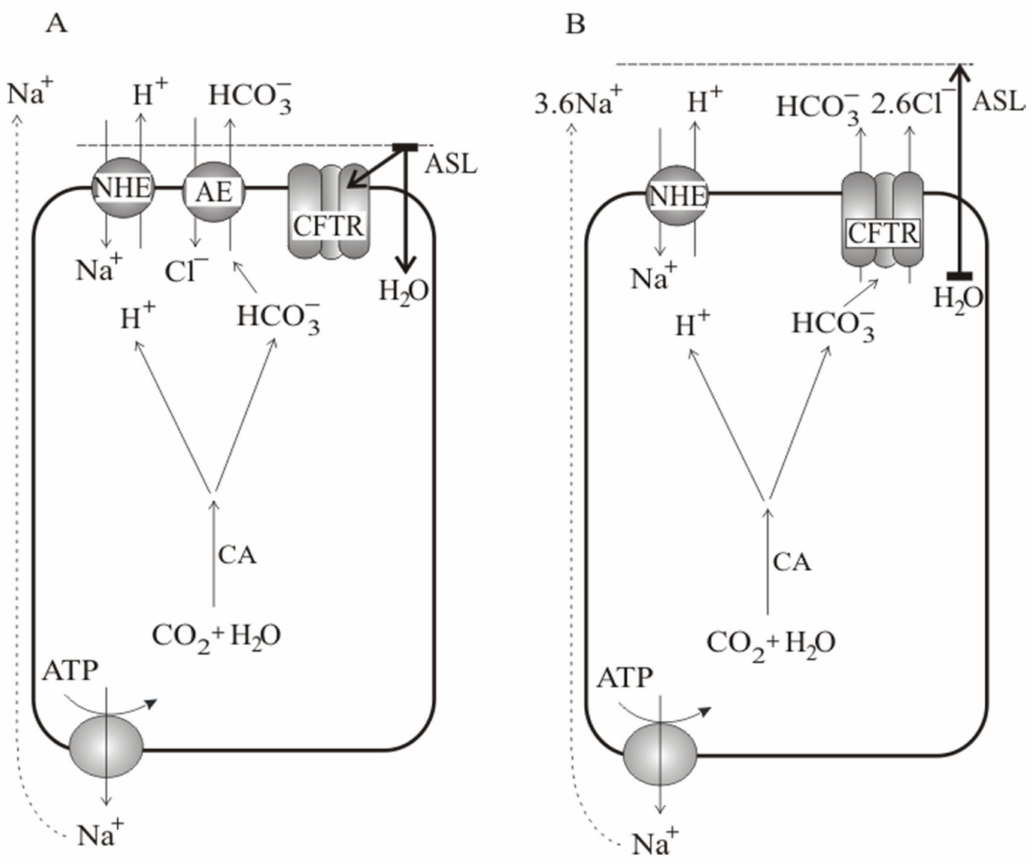
Figure 9. ‘The dynamic water balance’ hypothesis: ( A ) water absorption, ( B ) water secretion. During the absorption phase ( A ) two exchangers are responsible for sodium and chloride influx from ASL into the cytoplasm and outward proton and bicarbonate secretion. The lower osmotic pressure of partially dissociated carbonic acid in ASL causes water absorption and depletion of its volume, which increases the concentration of the ASL volume-dependent factor (e.g., ATP) triggering the opening of the CFTR channel and starting the secretion phase ( B ). The secretion of chloride and bicarbonate ions via the CFTR channel is accompanied by the transport of sodium ions via a paracellular pathway. The appearance of net 2.6 NaCl molecules on the apical side leads to osmotic water transport, ASL hydration and dilution of the triggering factor resulting in returning the epithelium to the absorption phase. In the absence of functional CFTR, the bronchial epithelium stays in the absorptive phase leading to Cl / HCO 3 reaching energetic equilibrium, the action of Na / H exchanger, acidification of ASL and undiluted